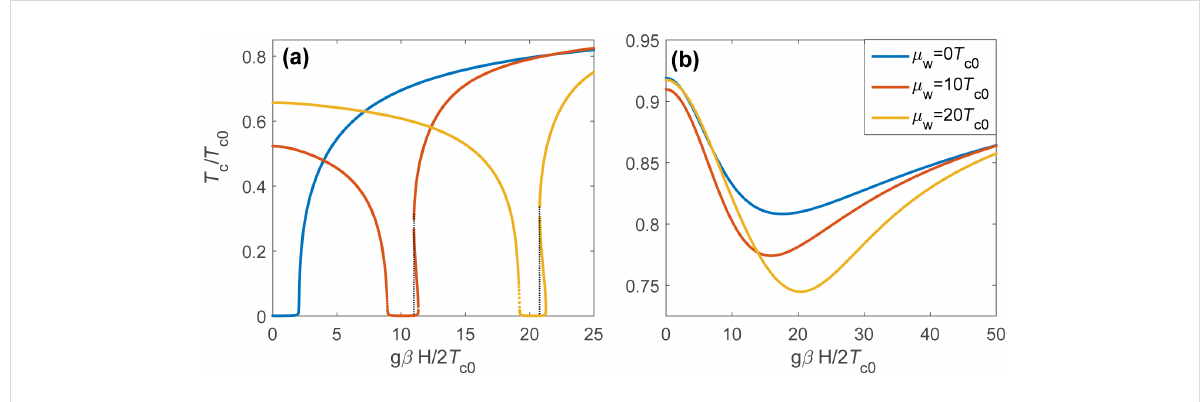
Figure 3: The critical temperature of the system as a function of the Zeeman field h for different values of the chemical potential in the wire μ w (shown in the legend). Here, ε so = 0.46 T c0 and Γ w = T c0 . (a) Γ s = 0.1 T c0 and (b) Γ s = 10 T c0 .